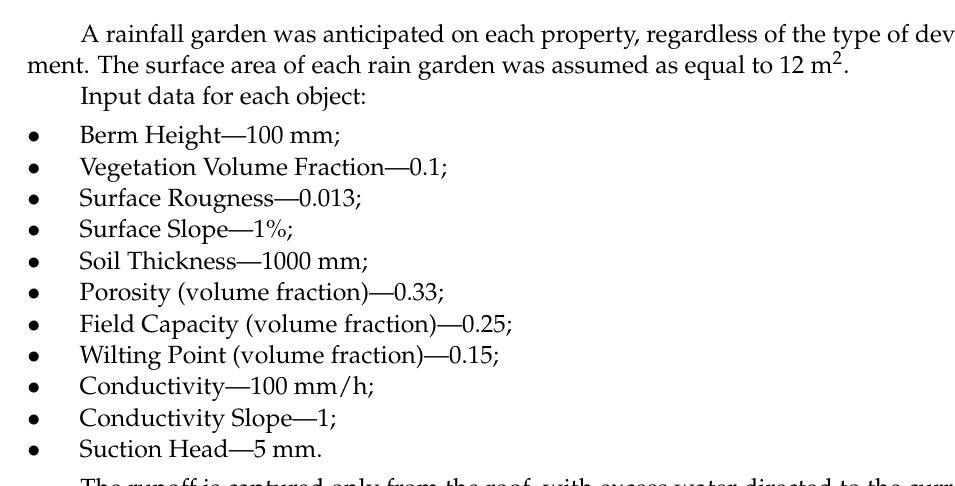
Figure 8. Rainfall scheme of Euler type II model—duration 45 min. (frequency of occurrence of modelled rainfall F = 5) [40,41].